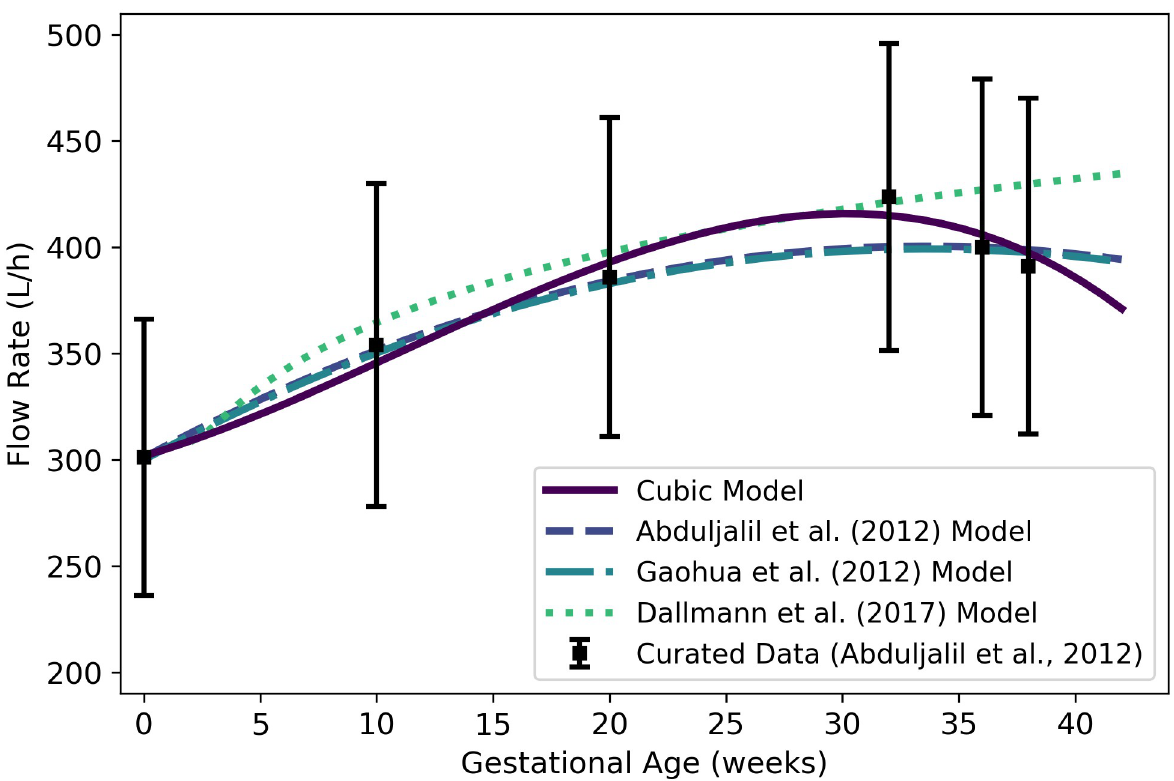
Fig 9. Maternal cardiac output vs. gestational age. The cubic model (solid line) given by Eq 13 was selected as the most parsimonious model in our analysis. The models of Abduljalil et al. [28] and Gaohua et al. [29], both of which are quadratic models, were calibrated using the same curated data set [28] used by us. Dallmann et al. [3] calibrated their model with different data.